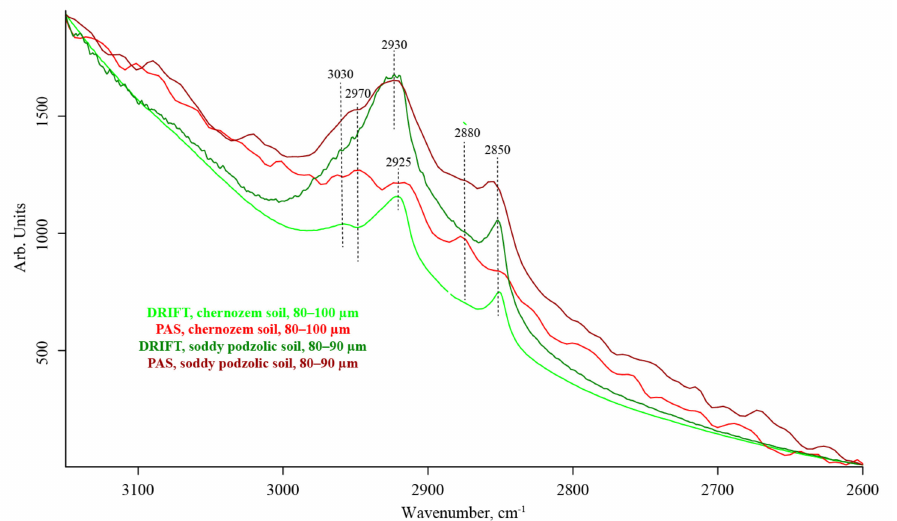
Figure 6. Normalized FTIR spectra in 3150–2700 cm − 1 . DRIFT and PAS (IMF 1.6 kHz) spectra of shelterbelt chernozem soil (dry fractionation, 80–100 µ m), light green and light red, respectively; and DRIFT and PAS (IMF 1.6 kHz) spectra of sod-podzolic soil (dry fractionation, 80–90 µ m), dark green and dark red,